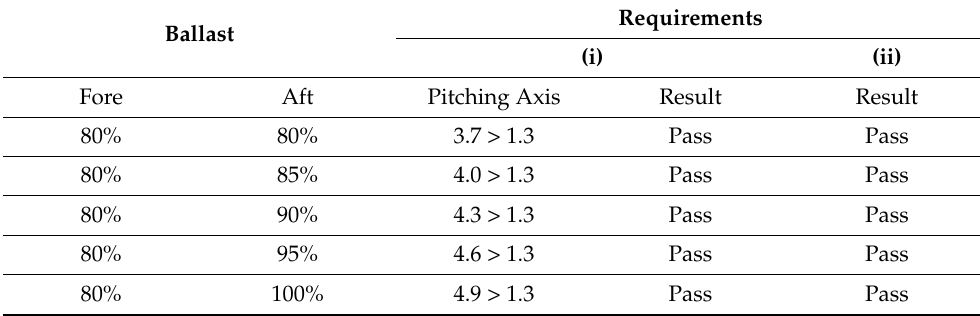
Table 11. SA: PB—DNV ST-0119 standard